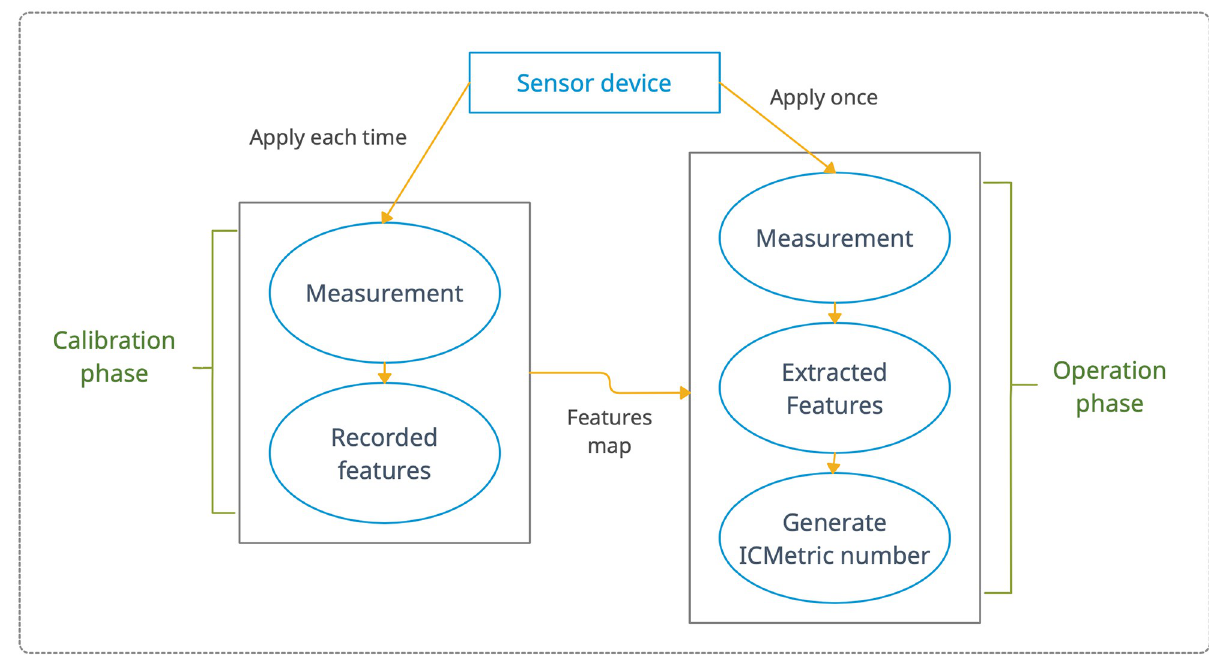
Fig 4. Flow diagrams of ICMetric phases